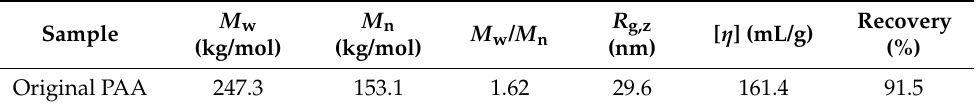
Table 1. Molecular parameters of original (6FDA-DMB) PAA in 0.02 M LiBr/0.20 M HAc/DMF, measured by GPC-RI-MALLS-VIS.